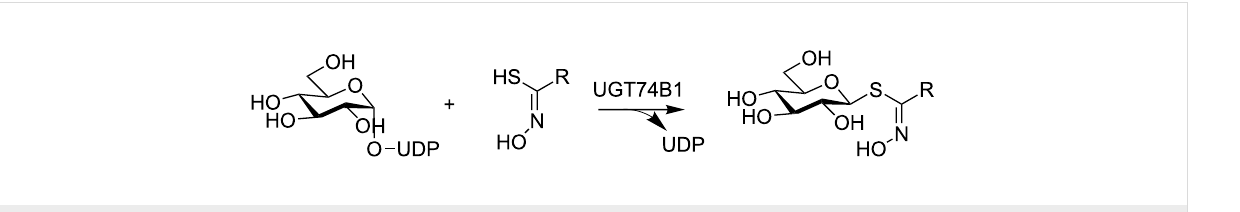
Figure 2: Desulfoglucosinolate biosynthesis by UGT74B1.